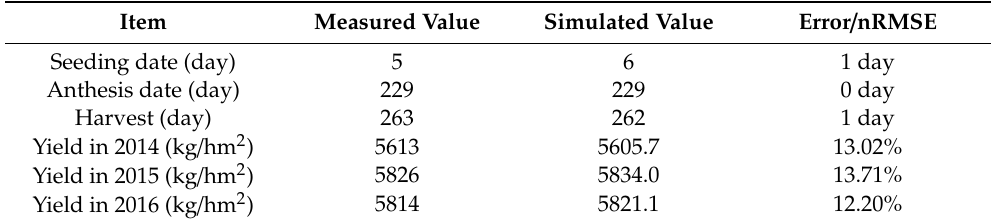
Table 6. Simulation error after calibration in the (Decision Support System for Agrotechnology Transfer) DSSAT